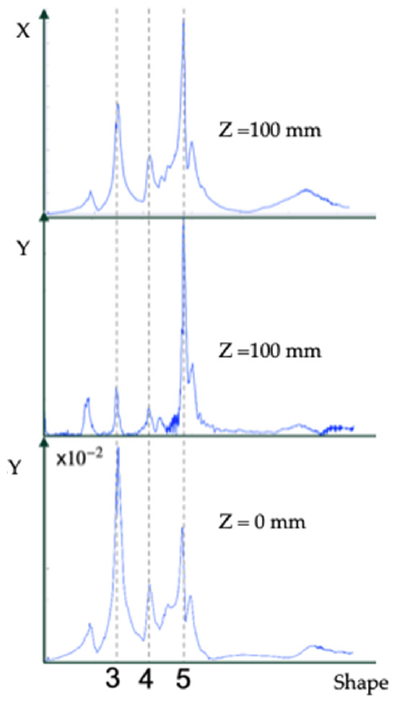
Figure 11. Laser vibrometer spindle measuring at 4250 rpm.